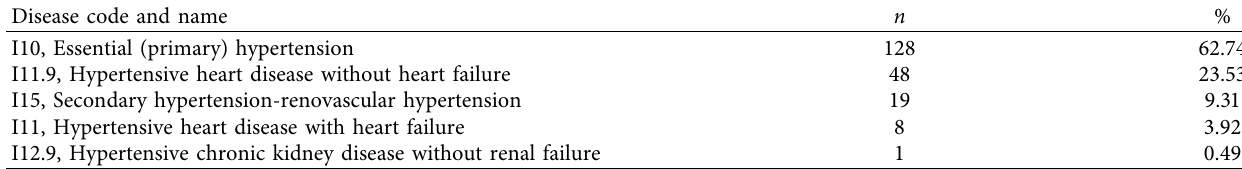
Table 2: ICD classification of the patients admitted to the hospital due to hypertension ( n � 204).